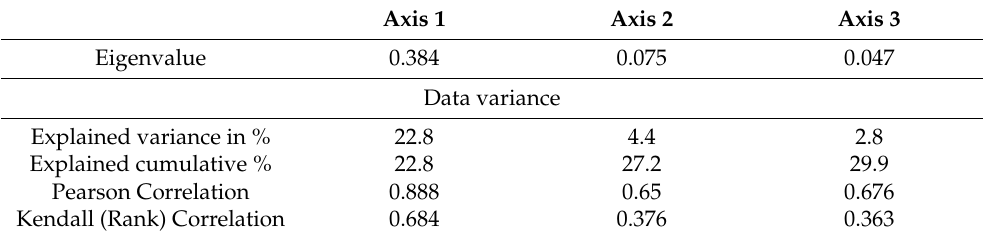
Table 4. Axis summary and commutative variance of the variables affecting Silybum marianum communities.